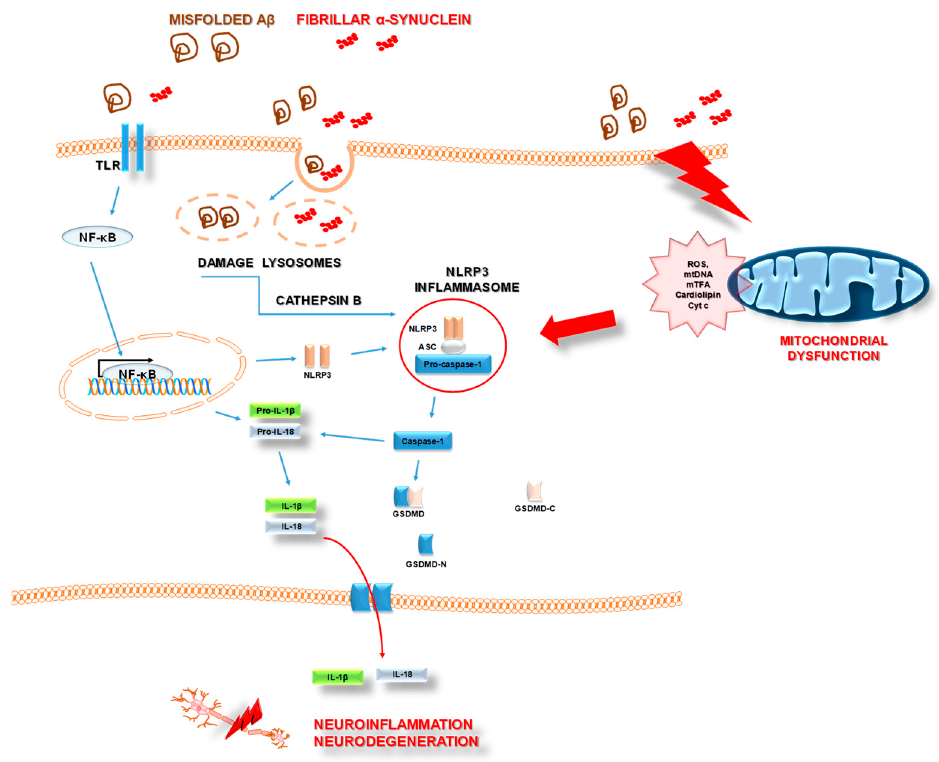
Figure 4. The scheme of the signaling cascade associated with NLRP3 inflammasome activation in Alzheimer’s disease and Parkinson’s disease. A β (Amyloid β ); TLR (Toll-Like Receptor); NF- κβ (Nuclear Factor kappa-light-chain-enhancer of activated β cells); IL-1 β (Interleukin 1 β ); IL-18 (Interleukin 18); NLRP3 (nucleotide-binding oligomerization domain (NOD)-like receptor protein 3); ASC (adaptor apoptosis-associated speck-like protein containing a CARD); GSDMD (Gasdermin D); ROS (reactive oxygen species); mtDNA (mitochondrial DNA); mTFA (Mitochondrial transcription factor A); Cyt c (Cytochrome c). Details in the text.